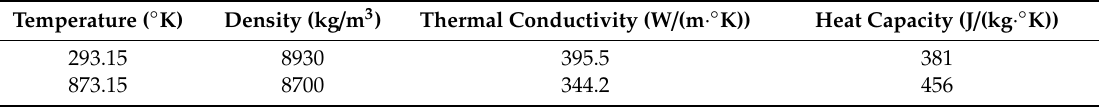
Figure 2. The tool electrode tip. Table 2. Thermophysical properties for copper [36].